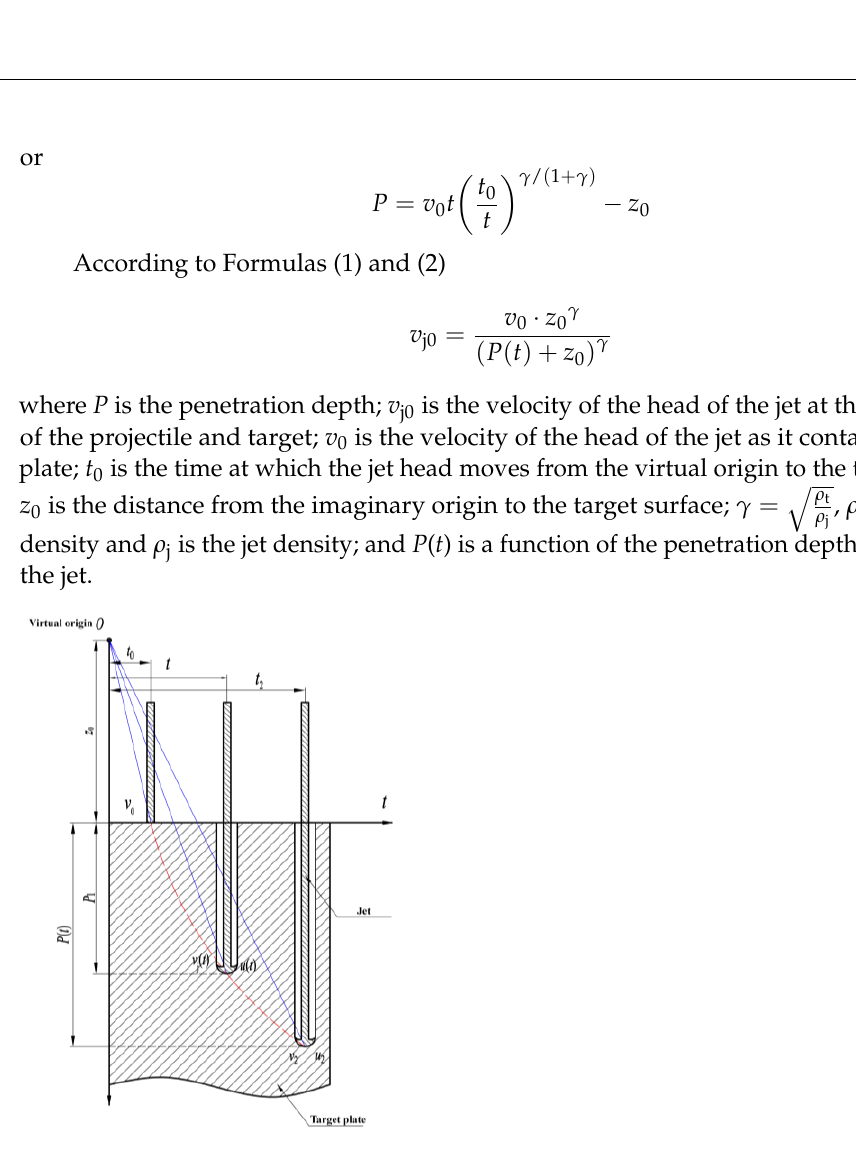
Figure 1. Jet penetration process diagram of virtual origin theory.